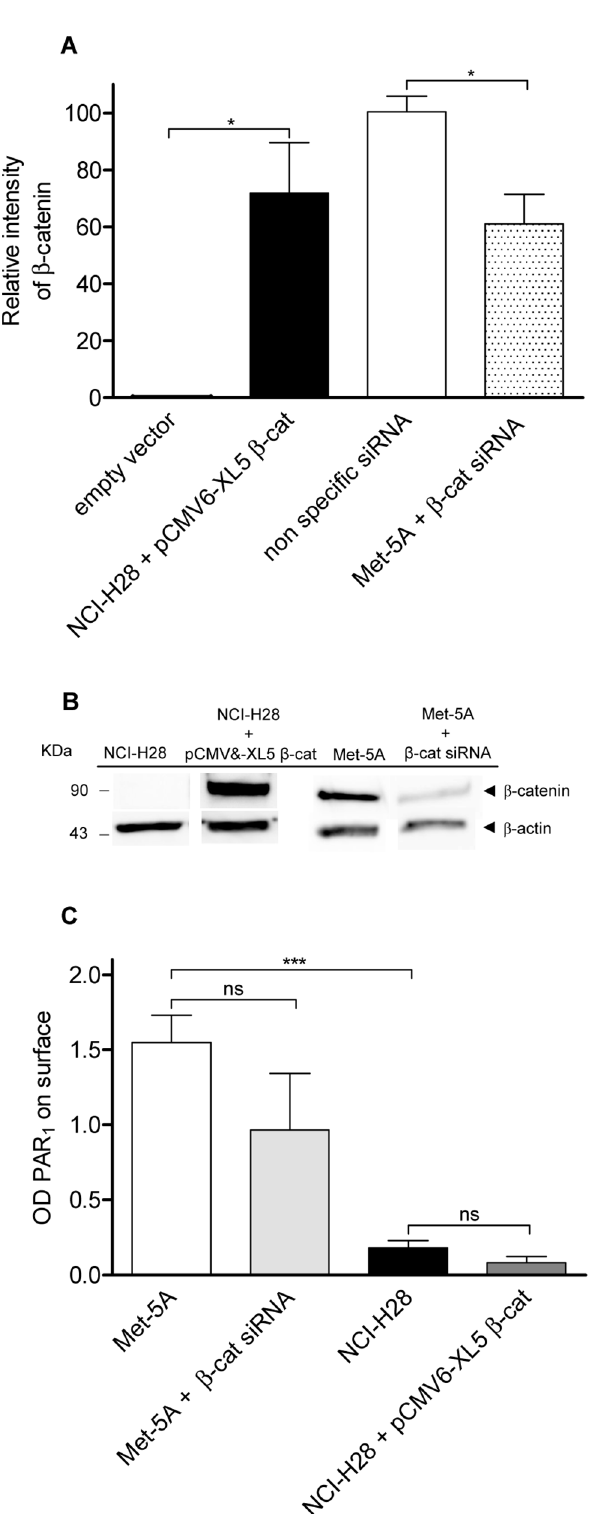
Figure 9. Neither b -catenin rescue nor deletion modify cell surface PAR 1 expression. NCI-H28 cells were transiently transfected with plasmide vector containing CTNNB1 or empty vector (Ctrl) while Met-5A cells were transfected with nonspecific (Ctrls) or specific b - catenin siRNA as described in Materials and Methods. A, relative expression levels of b -catenin. Transfected cells were lysed and total cell proteins were analysed by immunoblot using an anti- b